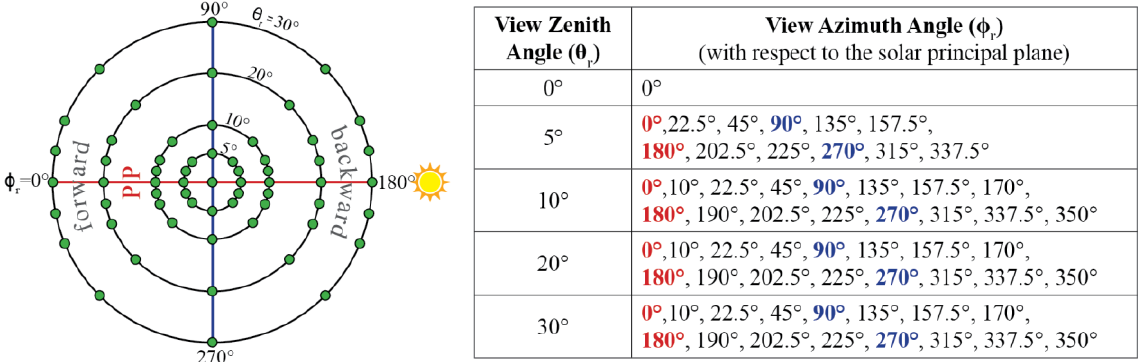
Figure 3. Default measurement scheme of the ManTIS field spectro-goniometer with overall 61 target measurements positions on the spanned spherical shell. The measurement scheme shows a higher measuring density around the solar principal plane